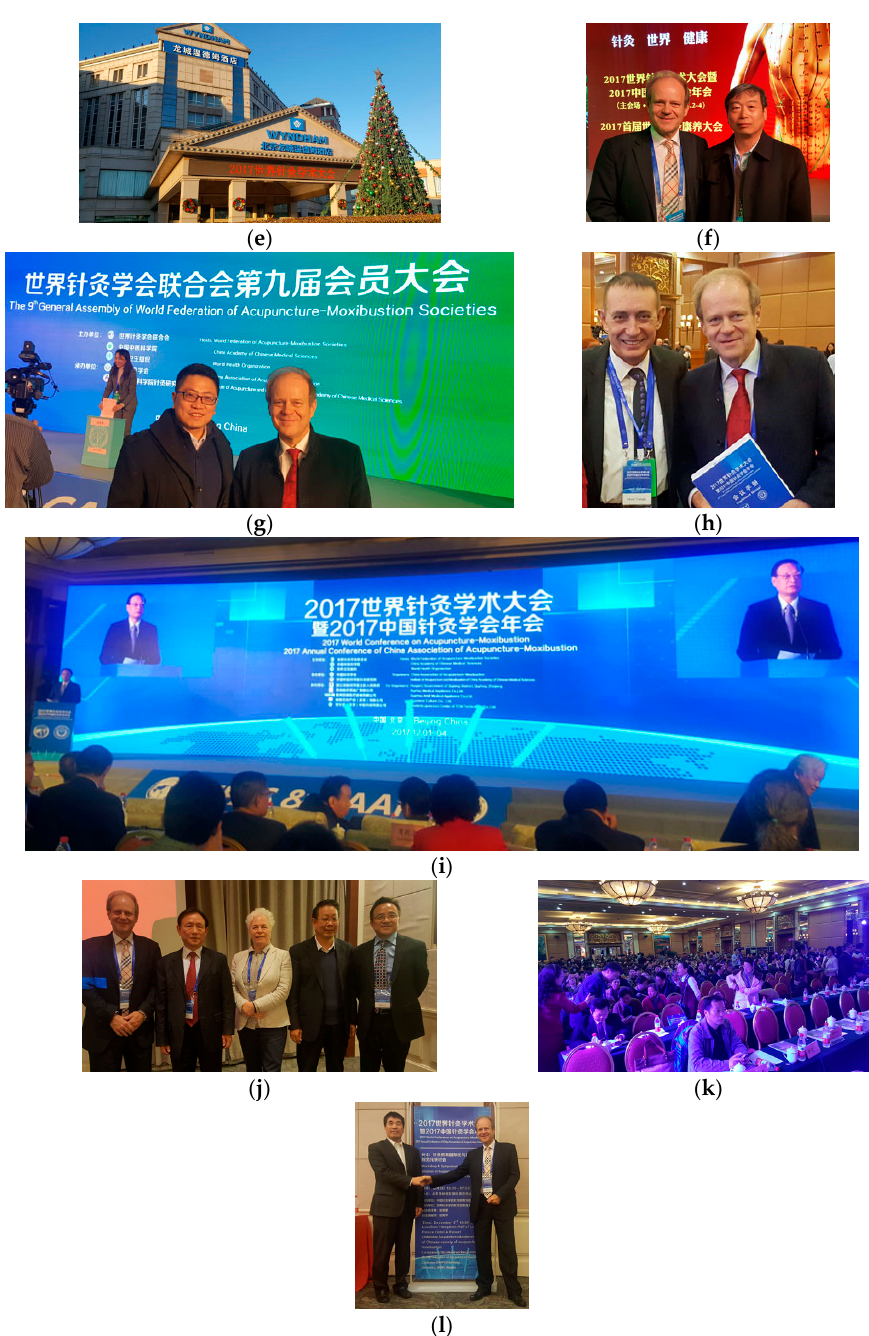
Figure 31. The Ninth General Assembly of the World Federation of Acupuncture: Moxibustion Societies (WFAS) and WFAS Congress ( a – l ). ( a ) Professor Liu Baoyan (Chairman of WFAS) and Professor Gerhard Litscher (left); ( c ) Professor Han Ji Sheng (left). ( d ) Professor Wang Hua (left), former President of Hubei University of Chinese Medicine; ( f ) Professor Zhang Weibo (right), China Academy of Chinese Medical Sciences; ( g ) Professor James Chen (left), Director of Traditional Chinese Medicine and Acupuncture Department of Beijing Tongren Hospital; ( h ) Dr. Murat Topoglu (left), President of the Turkish Acupuncture Society; ( i ) Dr. Wang Guoqiang, Honourable Vice Minister; ( j ) From left to right: Professor Gerhard Litscher, Professor Wang Hua, Dr. Judy James, Professor Guo Yi, and Professor Gary Lu; ( l ) Professor Shen Xueyong (left). Beijing, China, 2–4 December